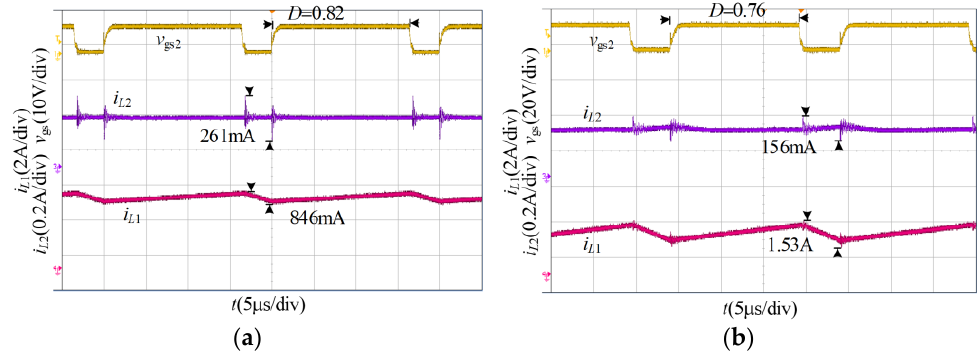
Figure 17. The stable experimental waveforms of i L 1 , i L 2 in step-up mode: ( a ) V 2 = 36 V; ( b ) V 2 = 48 V.